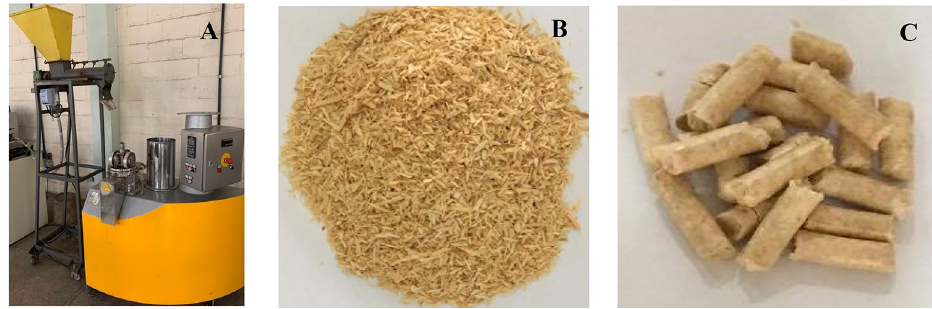
Figure 2. Pellets production. ( A ) Pelletizing machine press by Amandus Kahl, model 14–175. ( B ) Particles of Pinus sp. ( C ) Pellets